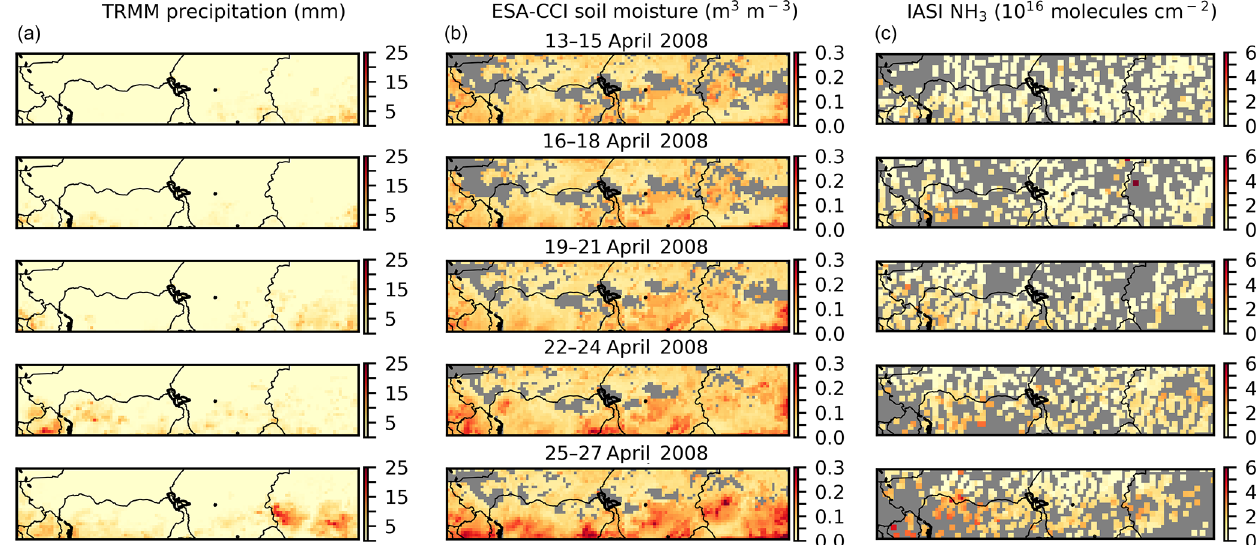
Figure 5. Maps of changing precipitation, soil moisture, and atmospheric NH 3 concentrations for the focal region of the Sahel during the second half of April 2008. 3-day averages from 13 April through 27 April are presented for precipitation from TRMM (a) , soil moisture from ESA-CCI (b) , and atmospheric NH 3 concentrations for acceptable retrievals from IASI (c) .